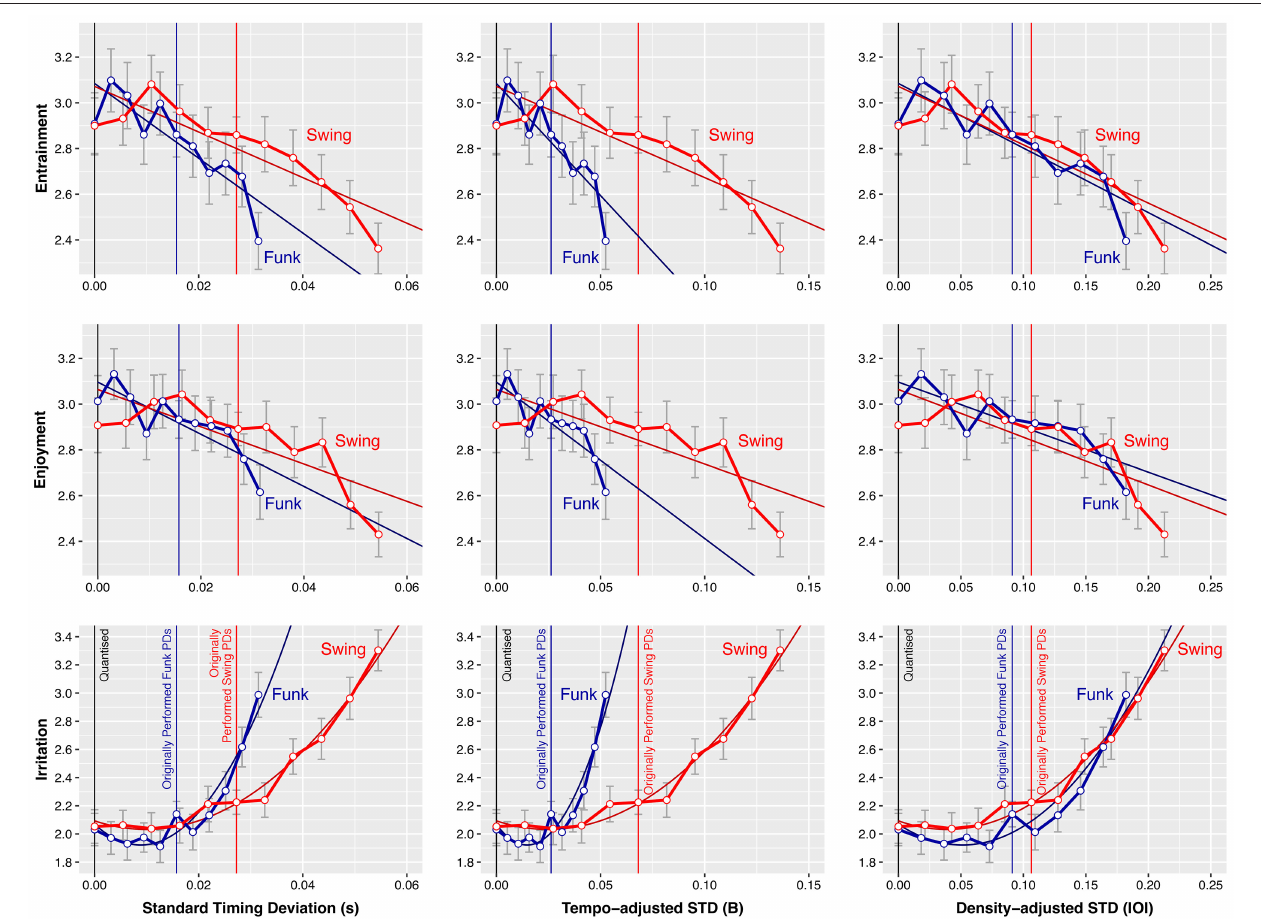
FIGURE 4 | Study B : Mean EAG variables ( Entrainment , Enjoyment , Irritation ) as a function of three microtiming magnitude measures, separated by Style ( Swing , Funk ). The Standard Timing Deviation measures microtiming magnitude in seconds (s), the Tempo-adjusted Standard Timing Deviation measures it as a proportion of mean beat duration (B), and the Density-adjusted Standard Timing Deviation as a proportion of mean IOI. Error bars represent the standard error of the